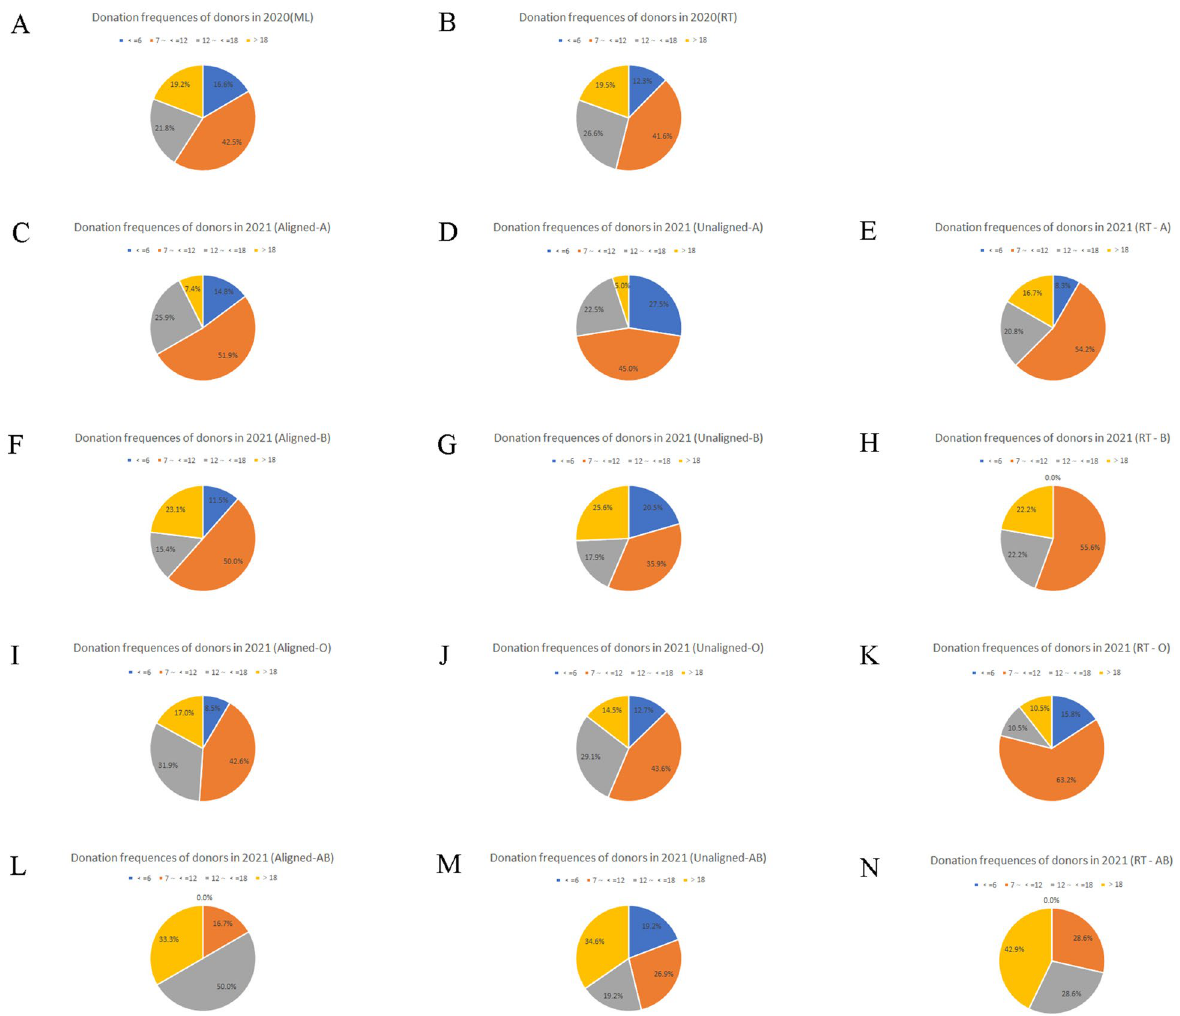
Figure 7. Statistics of donation frequency (months/times) in pandemic recruitment. The donation frequency characteristics of blood donors recruited were analyzed, donors with donation frequency between 7 and 12 months/times made up the majority of donors who were successfully recruited during the pandemics. ( A ) Donation frequency of donors in 2020 (ML). ( B ) Donation frequency of donors in 2020 (RT). ( C ) Donation frequency of donors in 2021 (Aligned-A). ( D ) Donation frequency of donors in 2021 (Unaligned-A). ( E ) Donation frequency of donors in 2021 (RT-A). ( F ) Donation frequency of donors in 2021 (Aligned-B). ( G ) Donation frequency of donors in 2021 (Unaligned-B). ( H ) Donation frequency of donors in 2021 (RT-B). ( I ) Donation frequency of donors in 2021 (Aligned-O). ( J ) Donation frequency of donors in 2021 (Unaligned-O). ( K ) Donation frequency of donors in 2021 (RT-O). ( L ) Donation frequency of donors in 2021 (Aligned-AB). ( M ) Donation frequency of donors in 2021 (Unaligned-AB). ( N ) Donation frequency of donors in 2021 (RT-